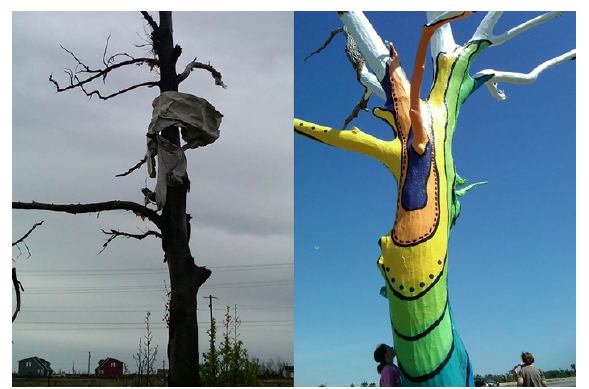
Fig. 7 . Depiction of the transformation of debarked trees in Joplin, Missouri from depressing reminders of tragedy to hopeful statements of rebirth and recovery. Photo: K. G.